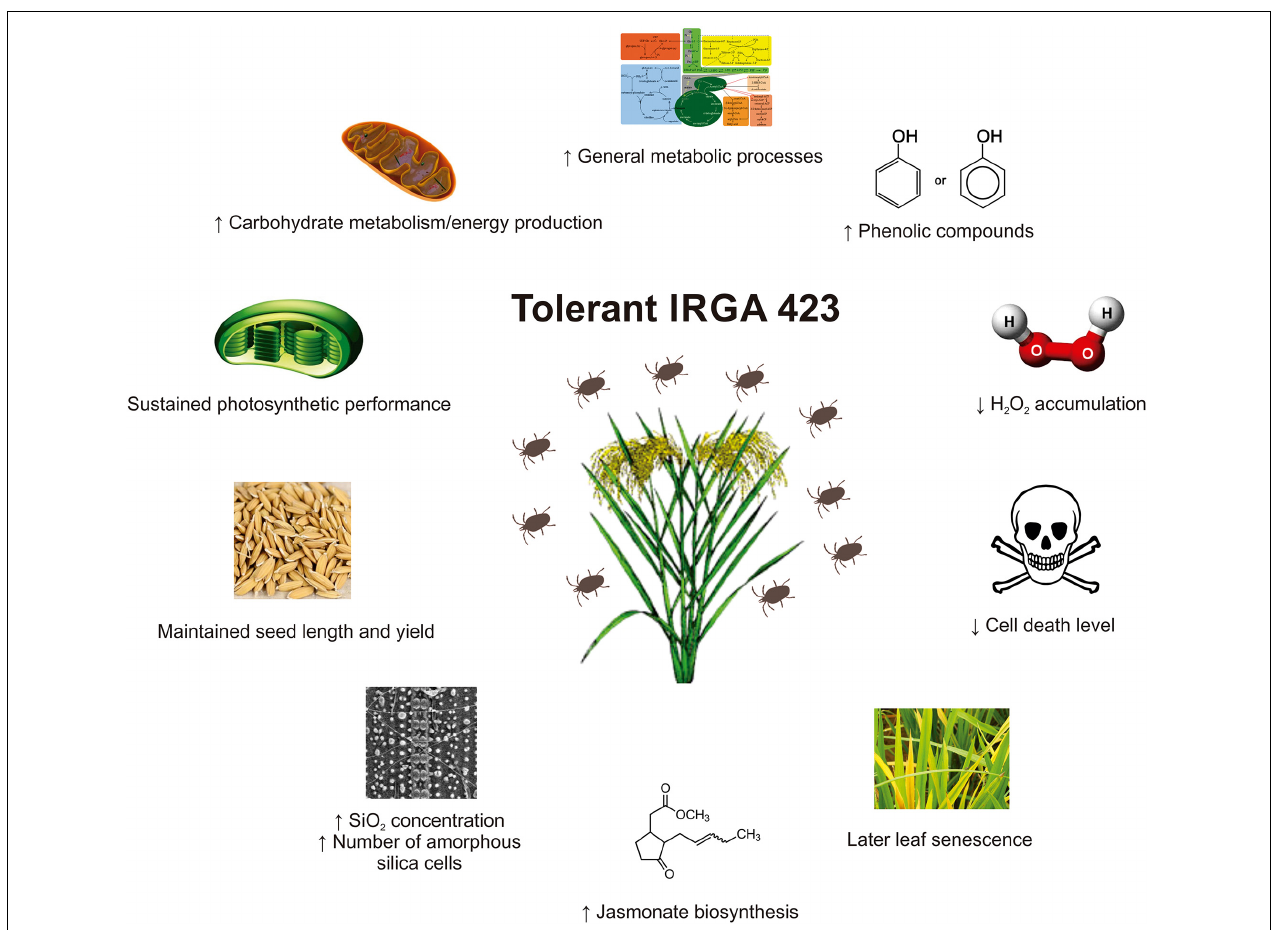
FIGURE 8 | Rice mechanisms employed by IRGA 423 cultivar to tolerate Schizotetranychus oryzae